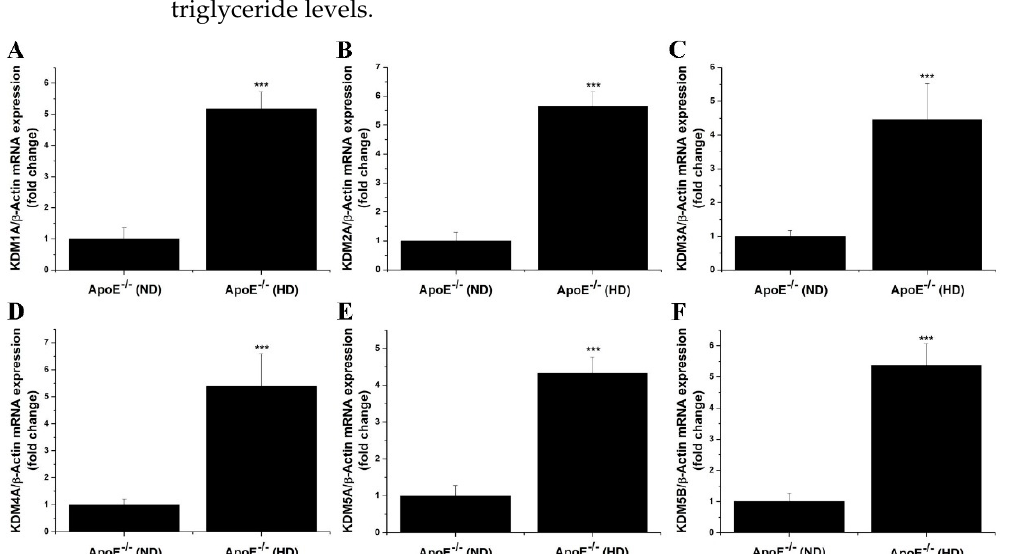
Figure 3. The mRNA levels of LSD1 and selective KDM subtypes induced in an experimental animal model of atherosclerosis. ( A – F ) Real-time PCR gene expression profiling analysis indicating the up-regulation of LSD1 (KDM1A), KDM2A, KDM3A, KDM4A, KDM5A, and KDM5B transcript levels in the atherosclerotic aorta of ApoE-/- mice. n = 4, *** p < 0.001. p -value was taken in relation to ApoE-/- (ND) condition.